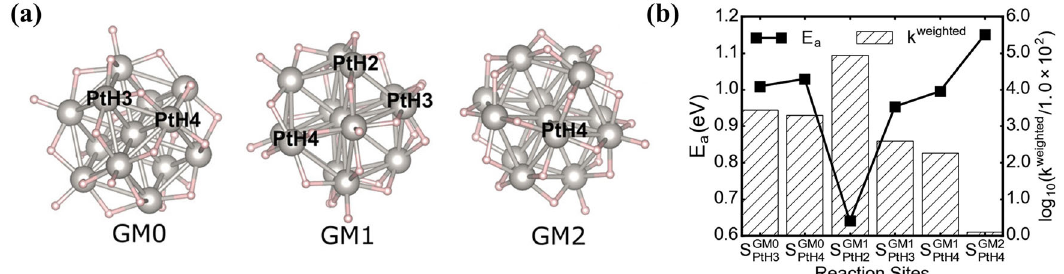
Fig. 3 Pt clusters for methane activation. a The geometries of top three stable Pt 13 H 26 clusters (denoted as GM0, GM1, and GM2) as explored by the HDNN potential together with modi fi ed genetic algorithm, in which the note ‘ PtH x ’ represents the coordination number (x) of Pt. b The activation energies (E a ) and relative contributions to the reaction rate of methane activation under 673 K. Reproduced with permission from ref. 97 . Copyright American Chemical Society, 2018.